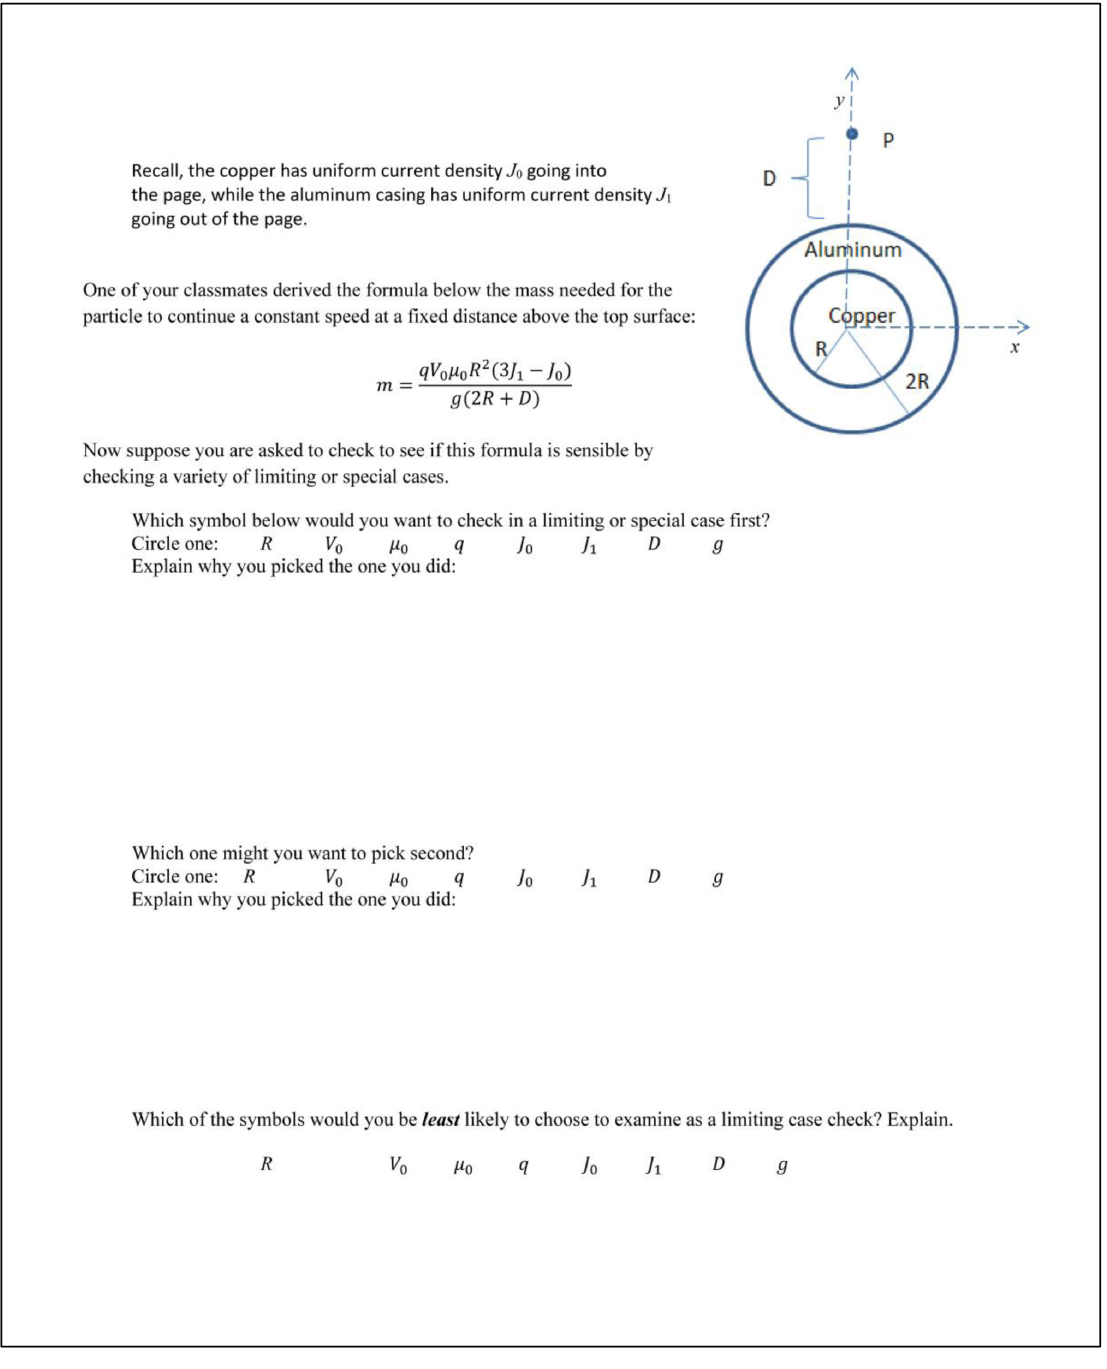
FIG. 14. Aluminum and copper wire problem referenced in Fig. 4, layer 3 of